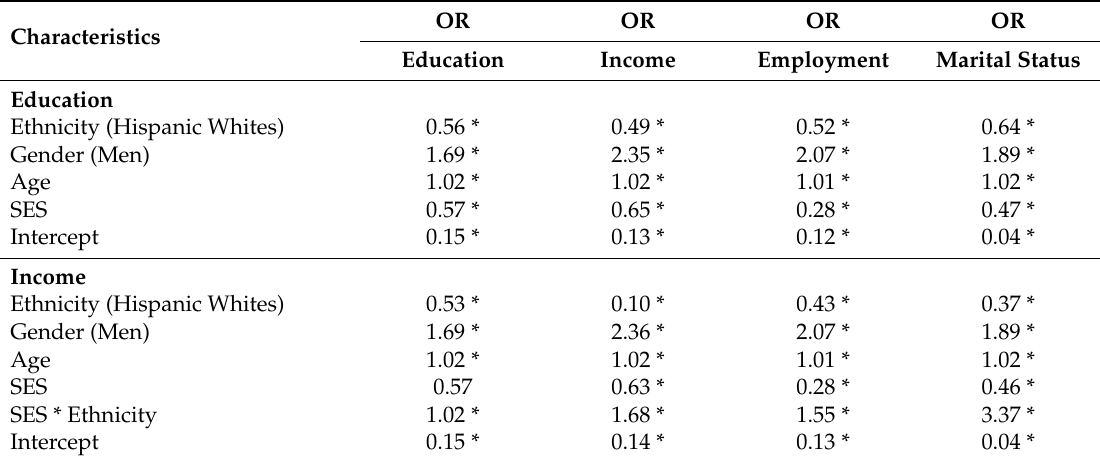
Table 3. Summary of logistic regressions between SES (education, income, employment, and marital status) and poor self-rated mental health (SRH) in the pooled